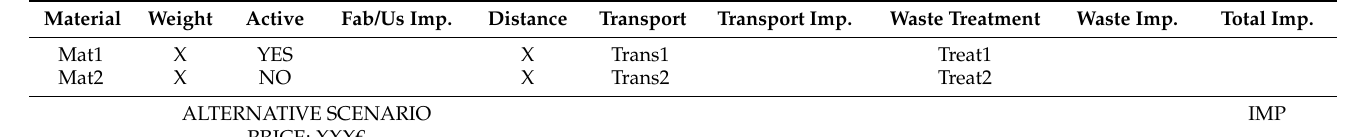
Table 4. Environmental impact of the design.